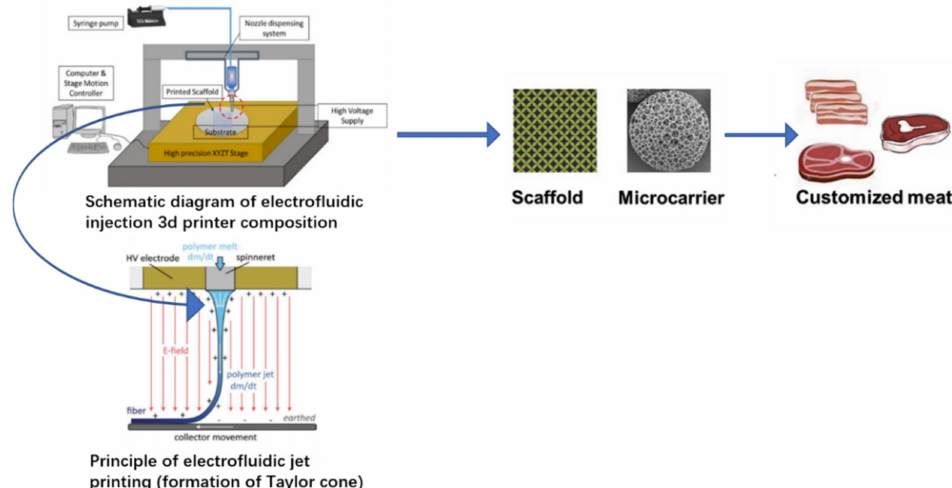
Figure 3. Three-dimensional printing process of cultured meat. Reprinted with permission from Reference [50] from American Chemical Society. Adapted from Reference [51], with permission from